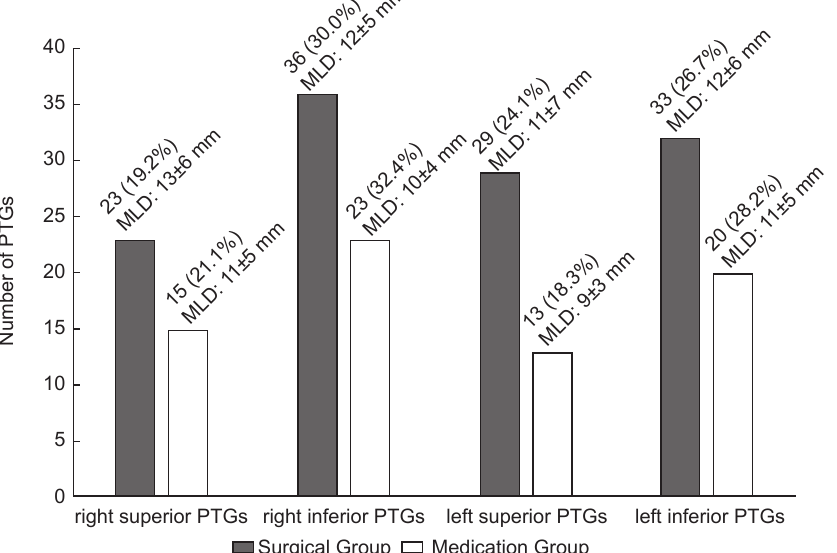
Groupleft superior PTGs left inferior PTGs Surgical Group Medication Figure 4 The distribution and maximal longitudinal diameters (MLDs) of US detectable parathyroid glands (PTGs) in surgical group and medication group.